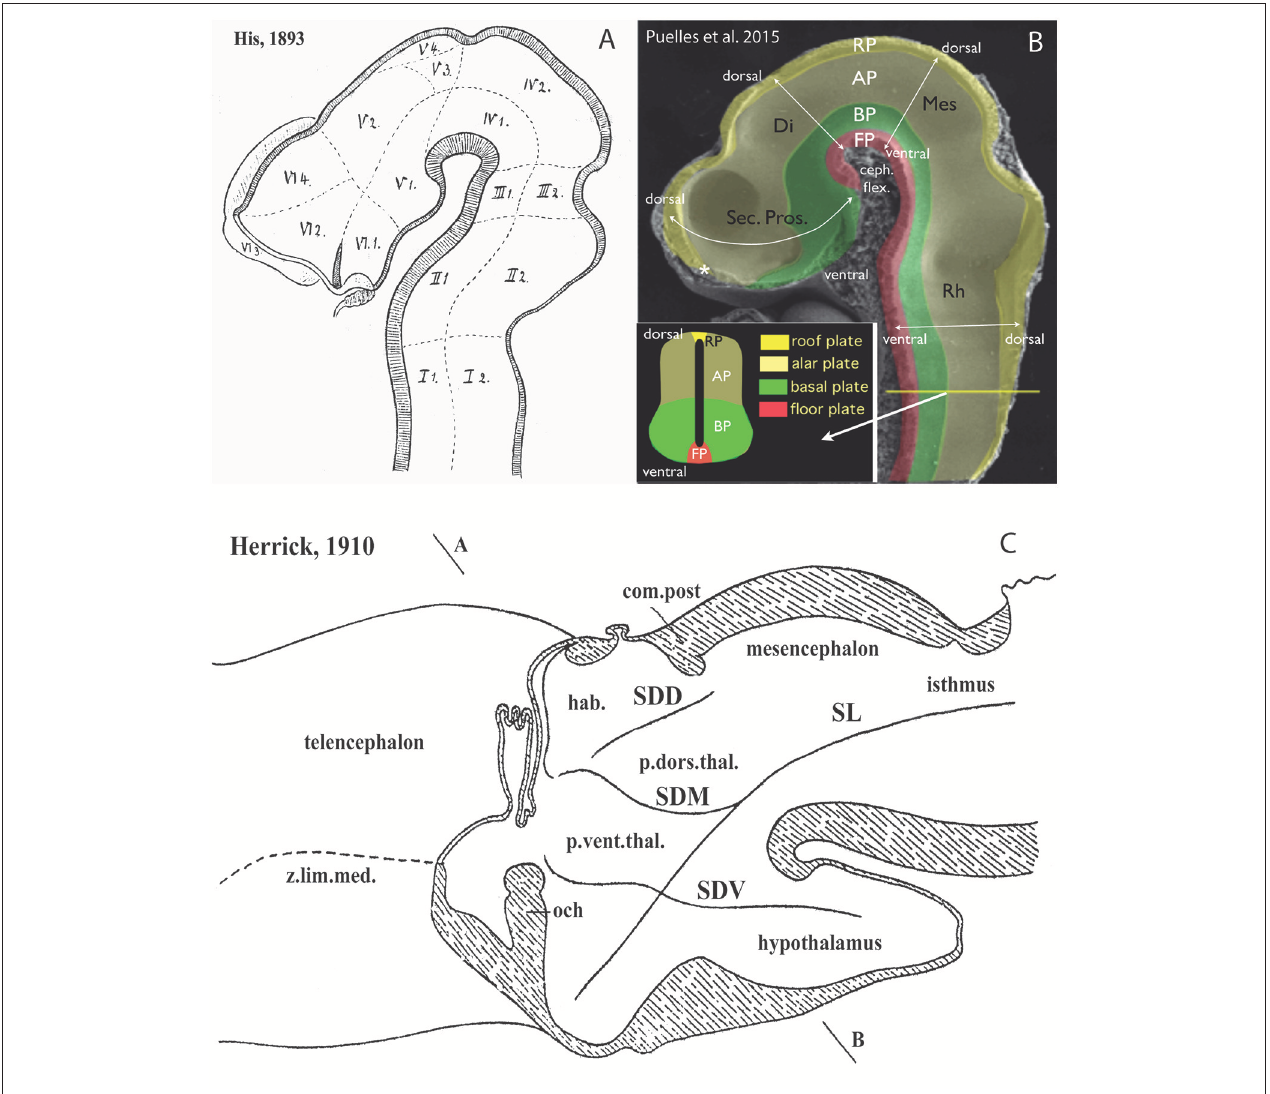
FIGURE 2 | Longitudinal vs. transversal neural tube directions in the conceptions of His (1893) (A) ; Martínez et al. (2012) and Puelles et al. (2015) (B) ; and Herrick (1910) (C) (no copyright permission required). (A) The pioneering view of His (1893) illustrates his original notion of axial longitudinal zones (floor, basal, alar, and roof plates) found throughout the brain; the common alar-basal boundary coincides with his sulcus limitans , which represents heterochronic differential neurogenesis prevalent at the basal plate (the sulcus is formed in early human embryos due to intraventricular bulging of the neurogenetically precocious basal plate, i.e., the set of domains I-VI numbered 1; the remaining domains represent the alar plate). A marked cephalic flexure is represented, and the axial landmark zones (floor, basal, alar, and roof plates) all bend around it, indicating a bent brain length axis. Theoretically transversal limits between the domains I–VI are also marked. Note the definition of an isthmic segment at the rostral end of the hindbrain (identified as III1 + III2). The midbrain (IV1 + IV2) appears delimited from the diencephalon sensu stricto (V1–V4) by a tentative oblique plane (later non-corroborated) that jumps from the middle of the posterior commissure to the mamillary body neighborhood. The hypothalamus was first defined by His in this schema as the sum of the V1 and VI1 domains, both entirely within the basal plate. The boundary separating V from VI has later been validated for the alar domains, but not for the basal ones. V1 underlies the alar “thalamus” and “epithalamus” (thalamic hypothalamus), while VI1 underlies the preoptic recess (optic hypothalamus) as well as the striate and parolfactory bodies (subpallium; VI2, VI3); the subpallium was accordingly held to reach the rostral part of the alar-basal boundary, at the preoptic recess (VI4 represents the telencephalic pallium). (B) This image, extracted from book chapters published in 2012 and 2015, shows the prosomeric assumptions about the longitudinal organization of the neural tube in a mouse embryo, which follow closely the model of His. The only difference is that the longitudinal zones are defined by primary early gene markers (rather than secondary differentiation patterns) and the rostral end of the alar-basal limit ends under the prospective optic chiasma, rather than at the preoptic recess (the sulcus limitans only approximates the primary (molecular) alar-basal boundary, due to its tertiary growth-related nature). In this image the floor (FP) is red, the basal plate (BP) green, the alar plate (AP) light yellow, and the roof plate (RP) strong yellow (see also the explanatory inset, a cut at spinal cord level); an asterisk marks the roof’s rostral end at the prospective anterior commissure. White arrows indicate the changing dorsoventral dimension due to the cephalic flexure of the brain axis. The floor ends rostrally at the mamillary pouch (correlative with an initial chordal induction and the early position of the notochordal tip). The rostral neural line extending dorsoventrally from the asterisk (roof) to the mamillary body (floor) represents (Continued)